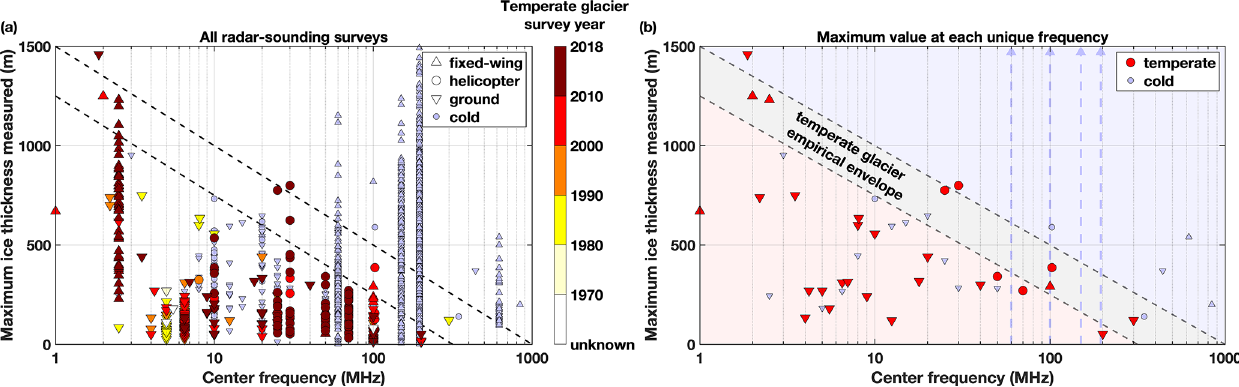
Figure 1. (a) Synthesis of all GlaThiDa v3.1.0 reported maximum ice thicknesses versus the center frequency of the deployed radar sounder and (b) a subset showing the maximum value for each unique frequency. “Cold” glaciers are either those from the polar regions or those in presumed temperate regions that are known to be polythermal (blue symbols). Symbol shape indicates platform type. Black dashed lines represent the lower and upper bounds of the empirical envelope of apparent best sounding performance for temperate glaciers. In panel (a) , for presumed temperate glaciers, symbol color indicates survey period (if reported). In panel (b) , the maximum measured ice thickness for cold glaciers at four frequencies (60, 100, 150 and 195MHz) exceeds the maximum value on the vertical axis (1500m), represented by vertical blue